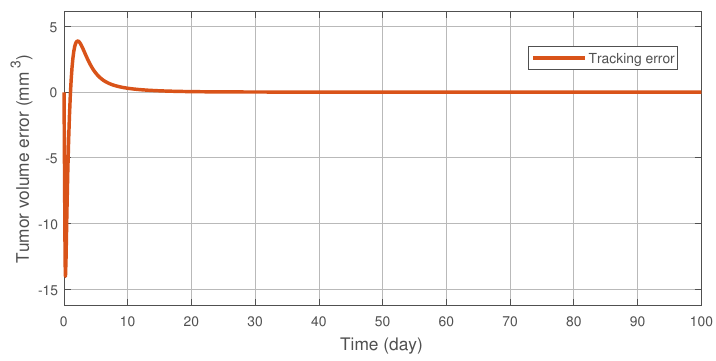
Figure 3. Tracking error of the RFPT